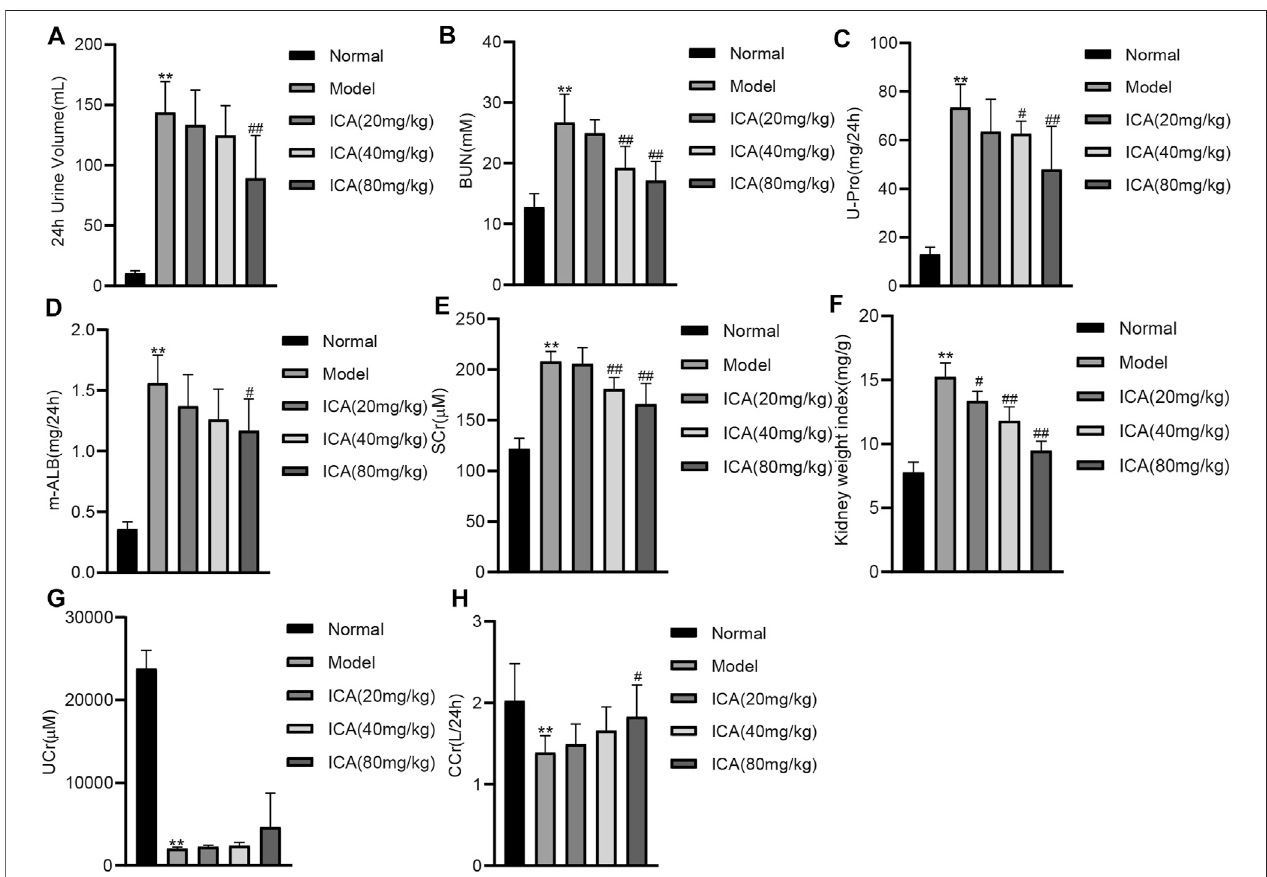
FIGURE 1 | ICA improves renal function in T2DN rats (A) The 24 h urinary volume (B) Blood urea nitrogen (BUN) (C) 24 h urinary protein (D) 24 h urine microalbumin (E) Serum creatinine (Src) (F) The ratio of kidney weight to body weight (G) Urinary creatinine (H) Creatinine clearance were measured by ELISA. Data are expressed as mean ± SD ( n (cid:1) 8). ** p < 0.01, vs the Normal group; # p < 0.05, ## p < 0.01, vs the Model